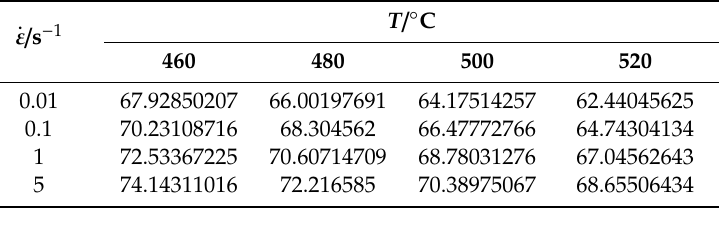
Table 3. The value of ln Z .